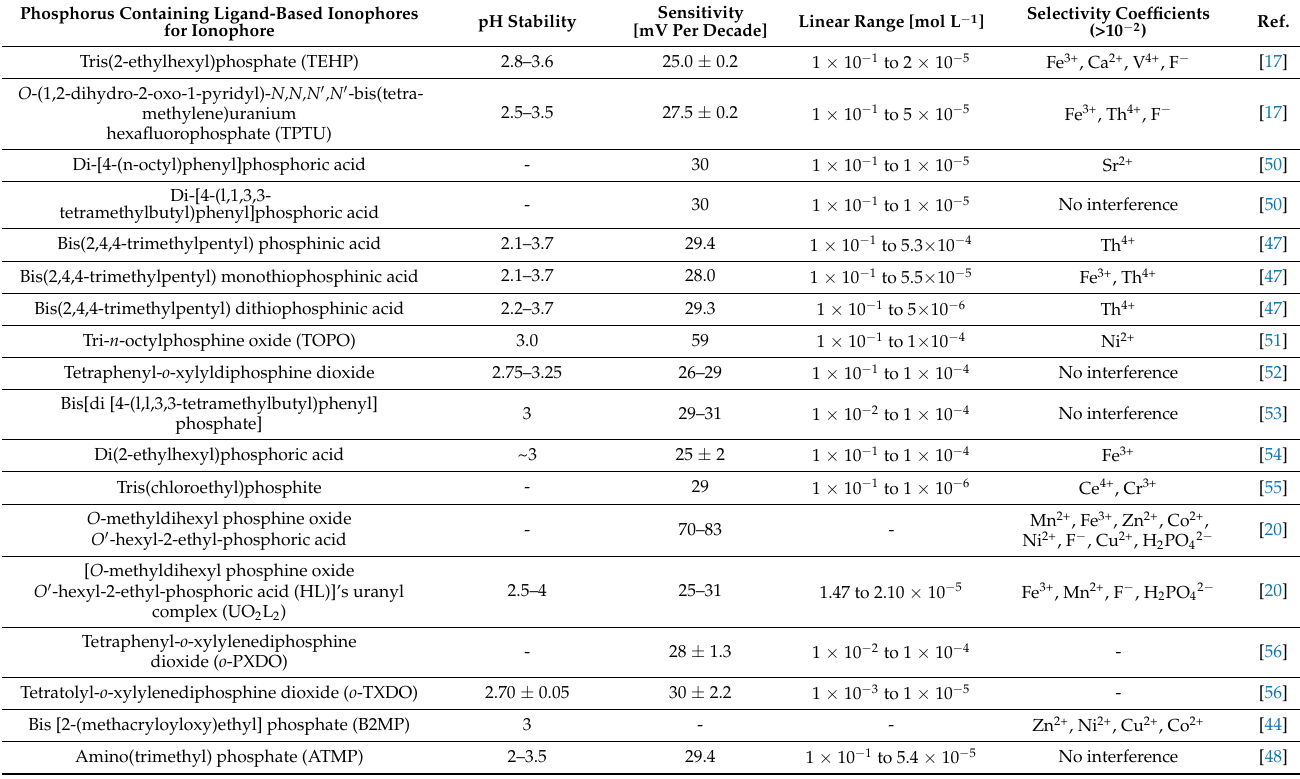
Table 3. An overview of uranium detection by PVC-based membrane electrodes with phosphorus- containing ligand-based